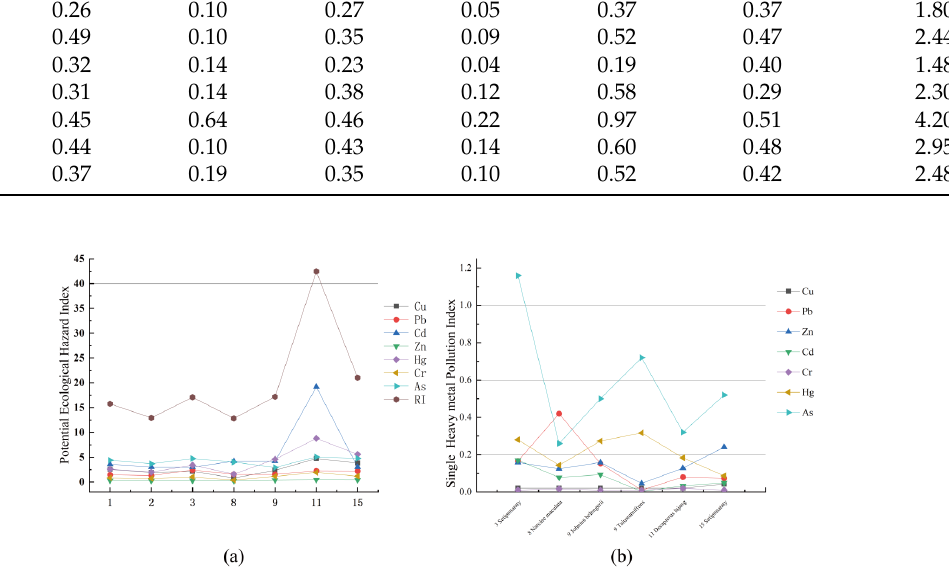
Figure 4. ( a ) potential ecological hazard index of sediment; ( b ) singe heavy metal pollution index of fish.